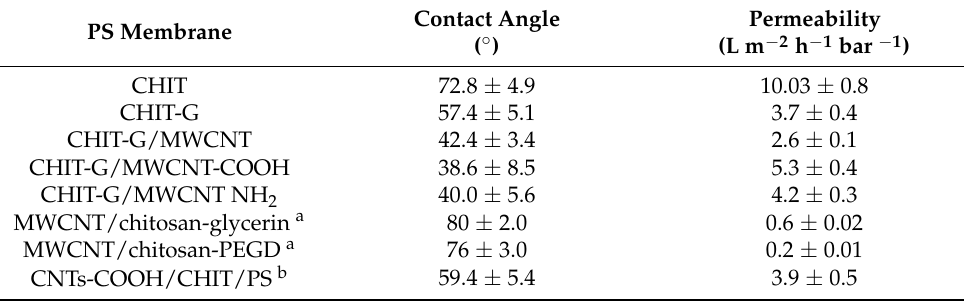
Table 1. Contact angles and water permeability.